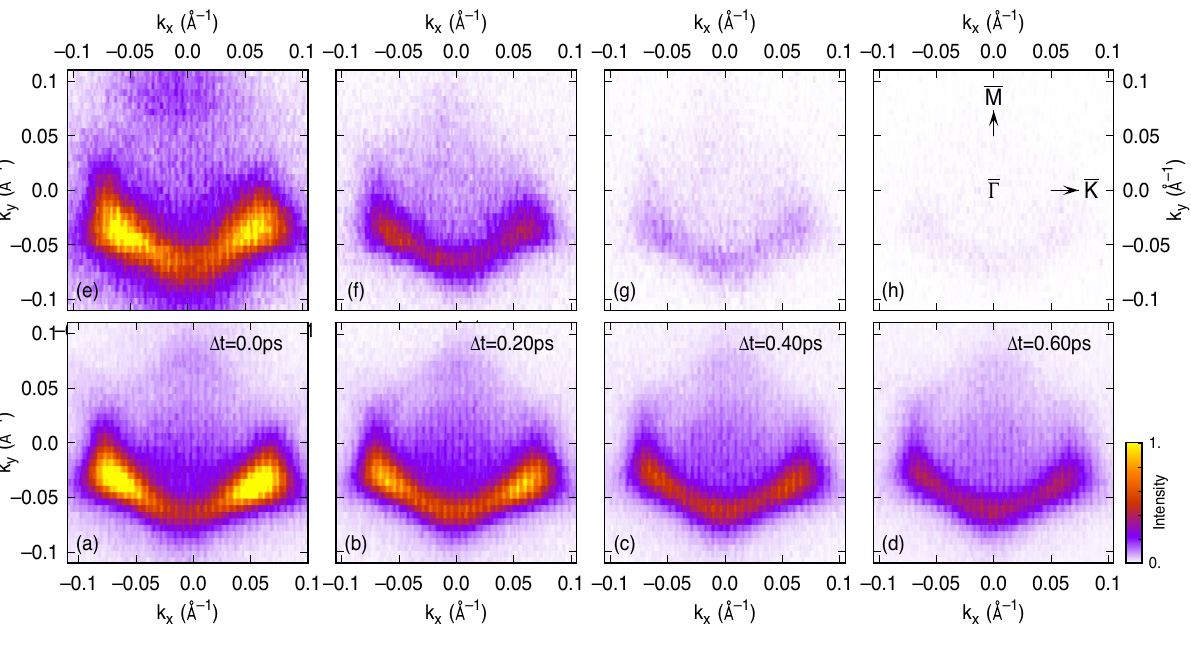
Figure 3. Comparison of the population dynamics between pristine Sb 2 Te 3 ( a – d ) and Sb 2 − x V x Te 3 with x = 0.015 ( e – h ). The panels show uncorrected k x – k y maps centered at E − E D = 141 meV for different time delays (cid:31) t . The sample orientation is indicated in panel ( h ). The plane of light incidence is along the k y -direction.